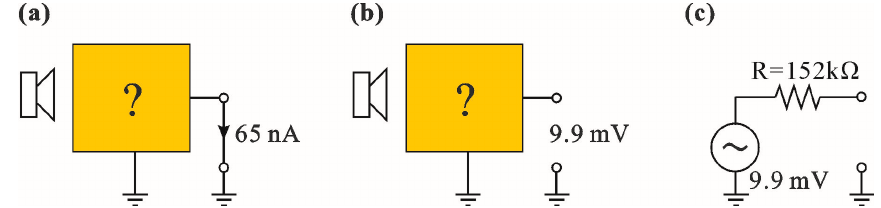
Figure 11. Black box method of signal source model evaluation: ( a ) current measurement at short circuit signal source; ( b ) voltage measurement at open circuit signal source; ( c ) resulting signal source model with the amplitude of 9.9 mV and internal resistance of 152 k Ω